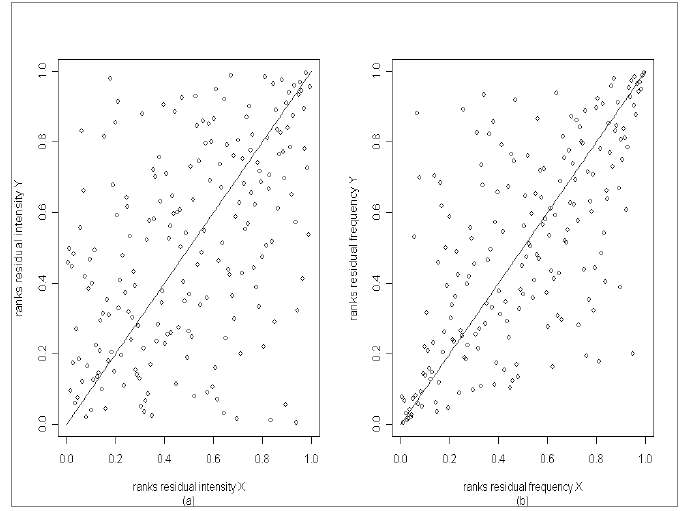
1 e ranks ij(i) 1 e ranks F 2 e ranks F ij(i) 0 versus 0 ij(i)